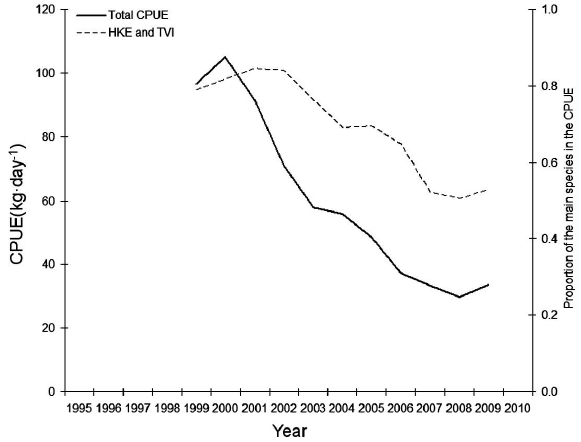
Fig. 2. – Trend in the total CPUE (kg day –1 ) and in the proportion of the Hilsa kelee and Tryssa vitrirostris in the total CPUE for the four provinces